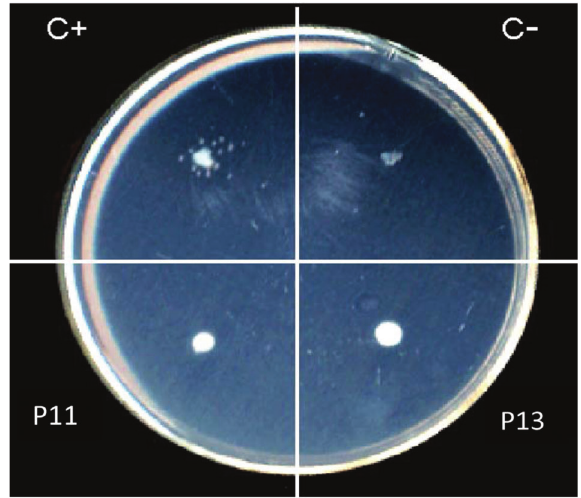
Figure 1. Aerobactin production on M9 agar with 200 m g 2,2 ’ - bipyridine. A positive test is indicated by the presence of satellite colonies around the isolate, as seen in the positive control (C + ). C – : negative control. P11 and P13 isolates are described